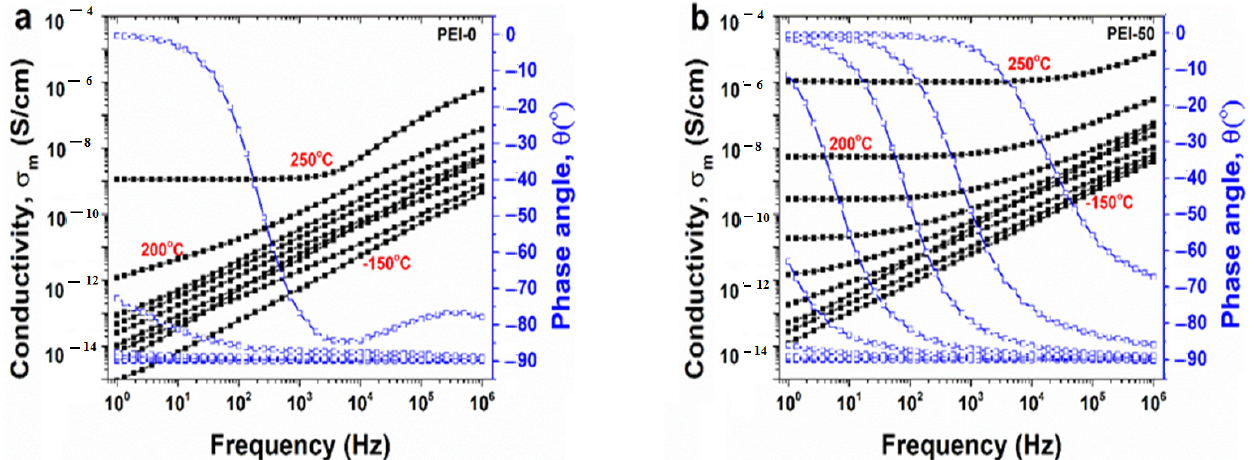
Figure 8. Evolution of the measured conductivity (left axis) and phase angle (right axis) as a function of frequency at various temperatures for the neat PEI-0 ( a ) and PEI-50 ( b ). The influence of the cobalt ferrite content on the conductivity of the PEI/CoFe 2 O 4 nanocomposites can be visualized in Figure 9 and Table 4.